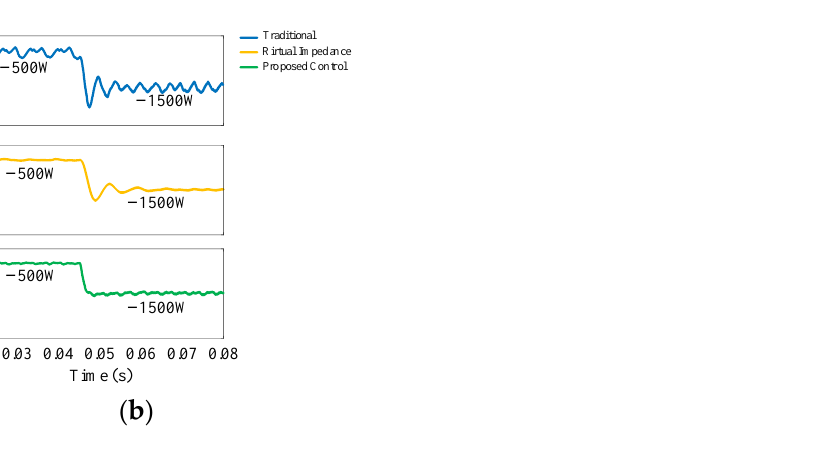
Figure 16. Simulation results with different control strategies at the low-power level as P changes, with U d = 155 V: ( a ) under forward power flow and ( b ) under reverse power flow.